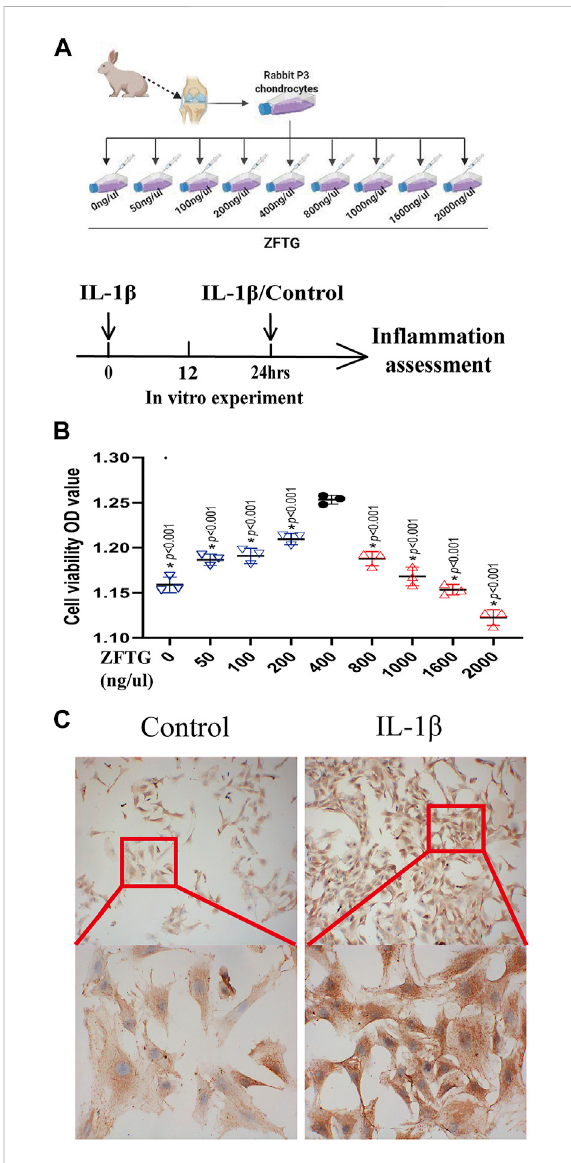
FIGURE 7 ZFTG enhances the activity of rabbit chondrocytes. (A) Experiment design for the cell. Primary chondrocytes obtained from rabbit knee cartilage (New Zealand rabbits, male, 3-month- old),weretreatedwithZFTG(0,50,100,200,400,800,1000, 1600, and 2000 ng/ μ l) to evaluate cell viability. Cells were treated with IL-1 β (10 ng/ml) for 24 h s (M IL-1 β ) to assess in fl ammation. (B) Cell viability after ZFTG intervention at various concentrations. (C) Expression of collagen II in chondrocytes of the control and IL-1 β groups. The images are magni fi ed 100× and 400×. One-way analysis of variance was used for comparing the cell viabilities. The data are presented as the mean ± SD. * p < 0.05, vs. the 400 ng/uL ZFTG group. Speci fi c p -values for each pair of comparisons are